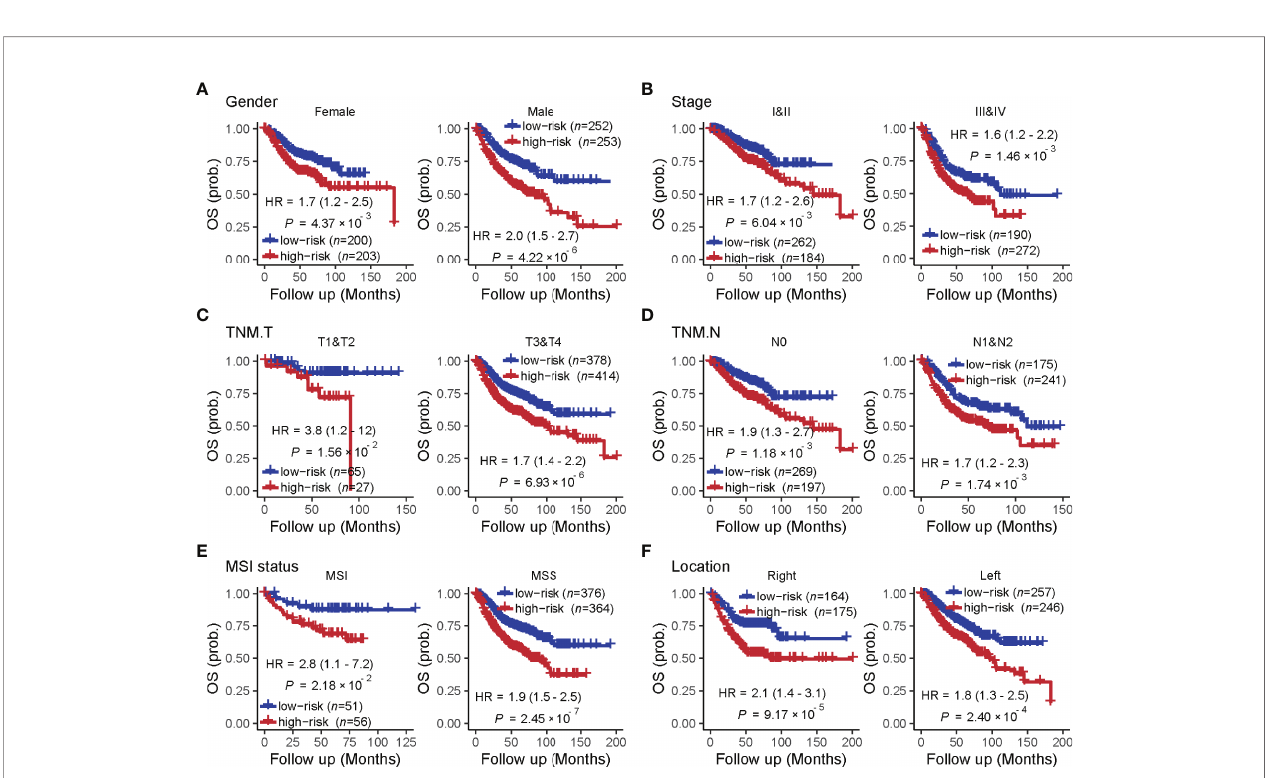
FIGURE 4 | The prognostic value of the TF-9 in colorectal cancer is strati fi ed by clinical characteristics. Even strati fi ed by (A) gender, (B) stage (I&II vs. III &IV), (C) T stage (T1&T2 vs. T3 &T4), (D) N stage (N0 vs. N1&N2), (E) MSI status (MSI vs. MSS) and (F) primary tumor location (right-sided vs. left-sided), TF-9 can still stratify patients into low- and high- risk groups with signi fi cant prognosis value.